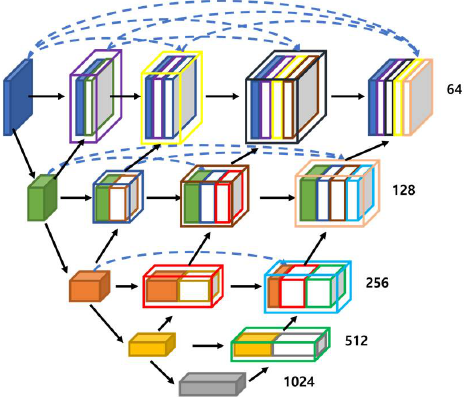
Figure 2. Structure of UNet++ model [7] .